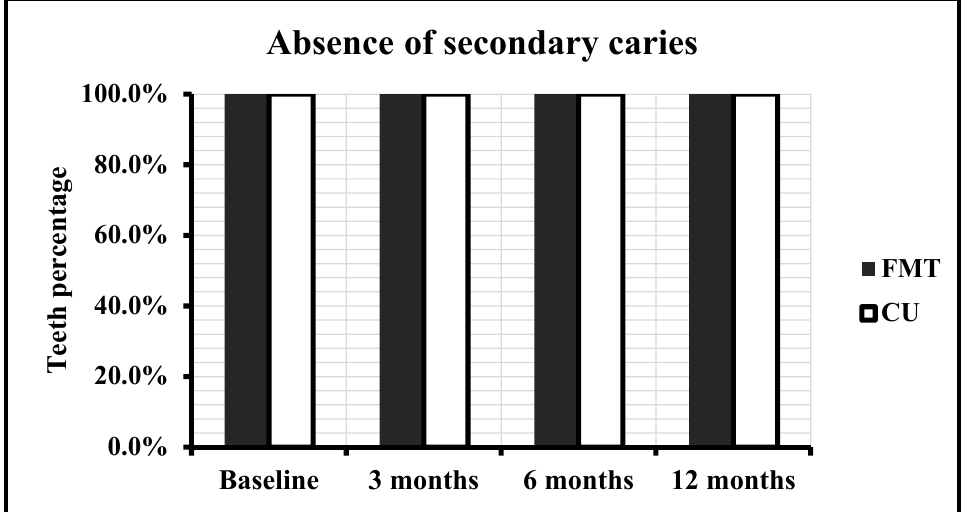
Figure 4. Absence of secondary caries in teeth restored with FMBT and CULT over time.